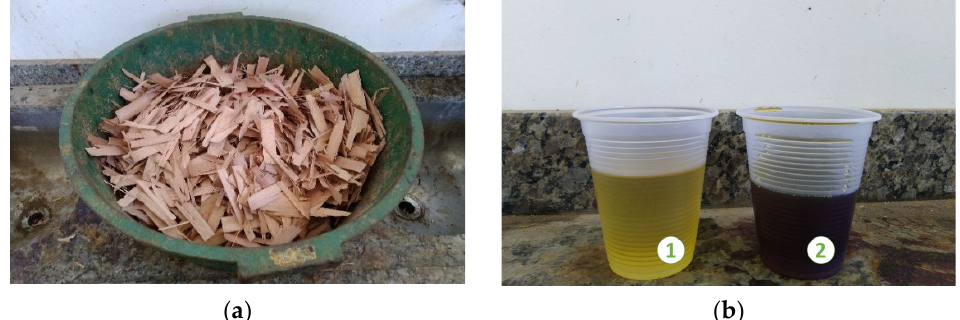
Figure 1. Materials used in the panels’ production: ( a ) wood, ( b ) adhesive components (polyol-1 and prepolymer-2).